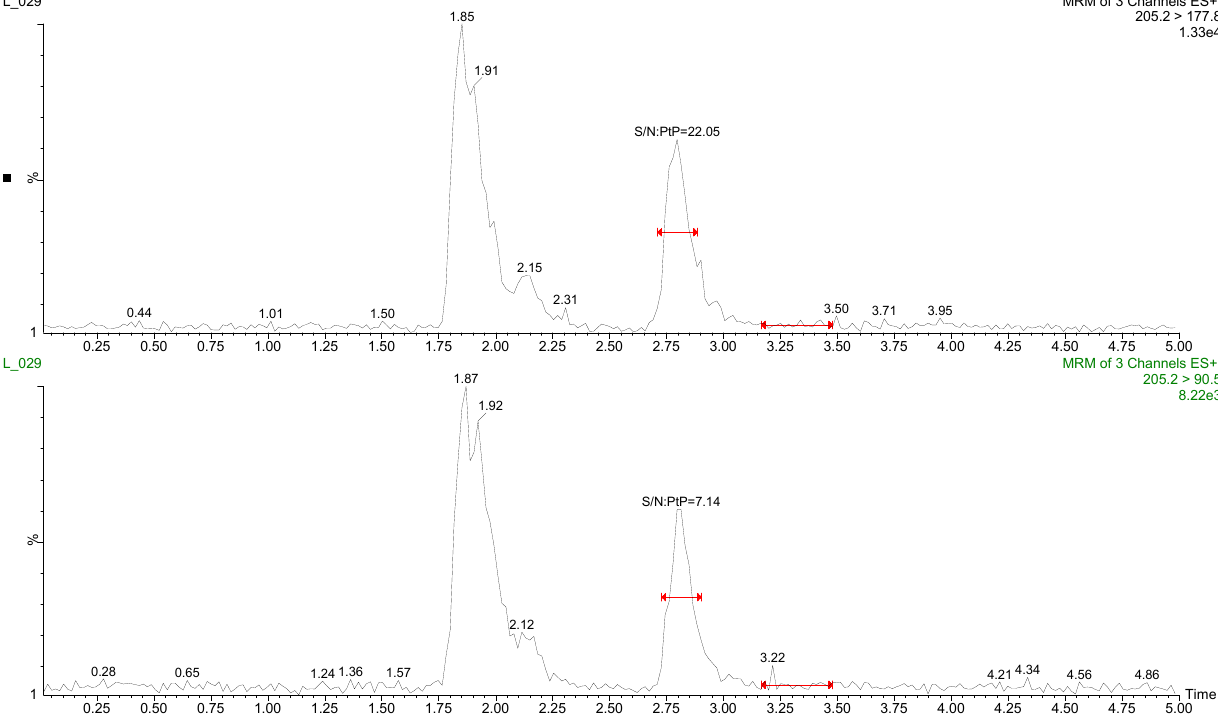
Figure A4. Chromatogram of the liver sample treated at the limit of quantification (LOQ) level.